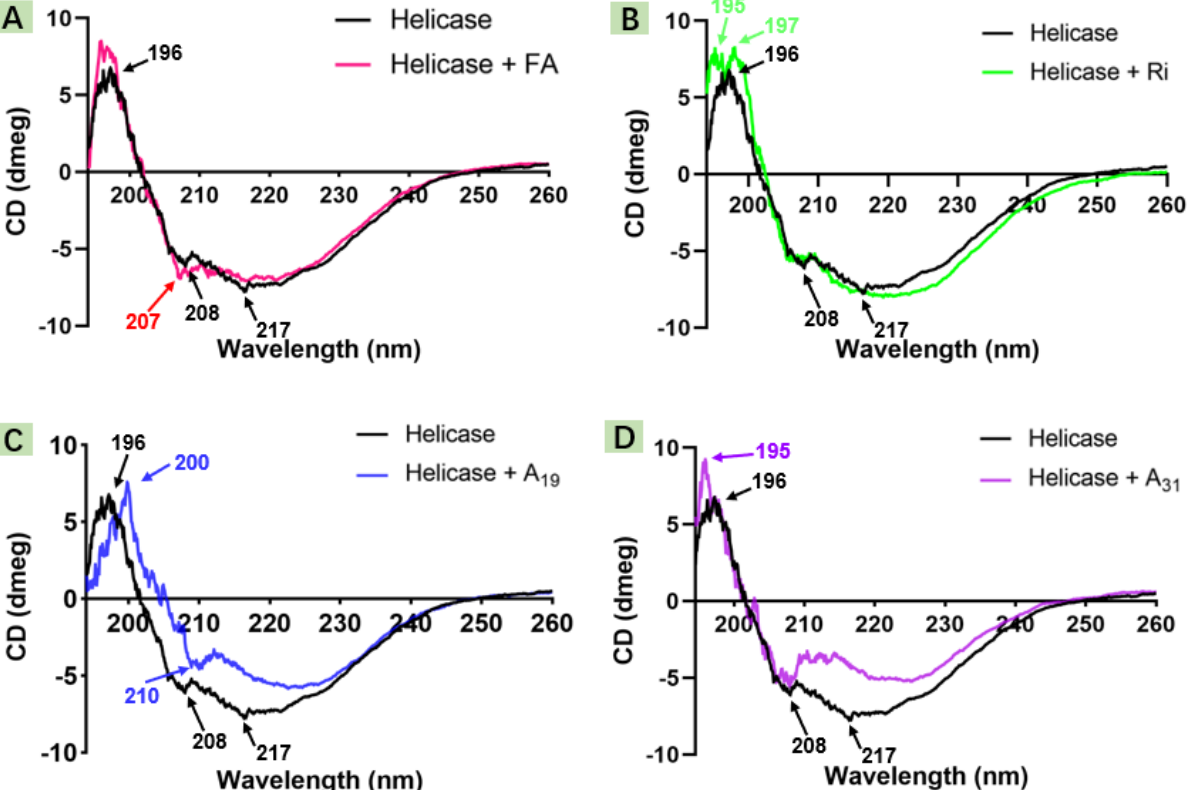
Figure 7. CD spectra changes in TMV helicase after with FA ( A ), Ri ( B ), A 19 ( C ), or A 31 ( D ), respec ‐ tively.